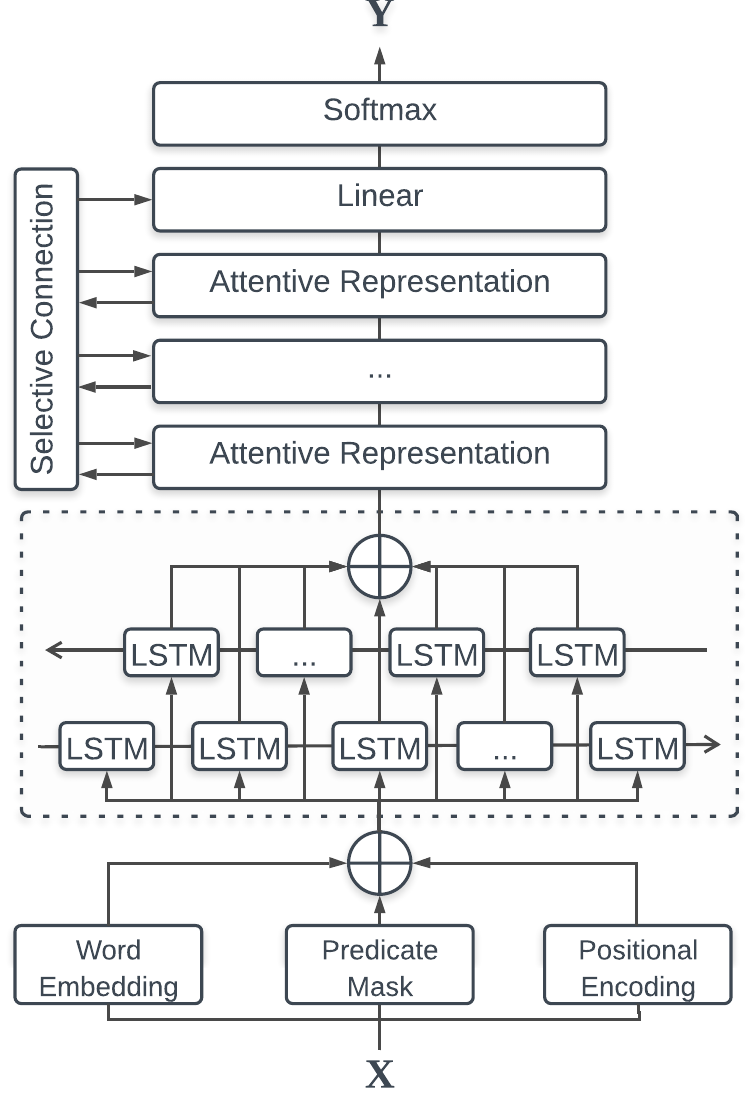
Figure 3. Selective